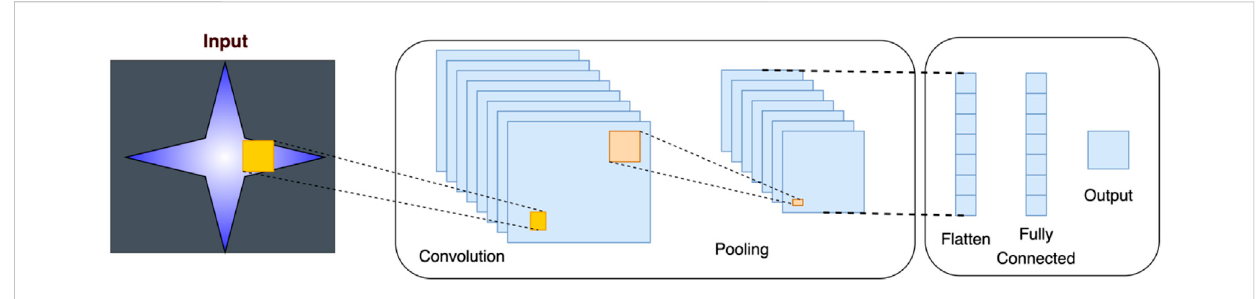
FIGURE 5 Convolutional neural network (Bhardwaj et al., 2018).